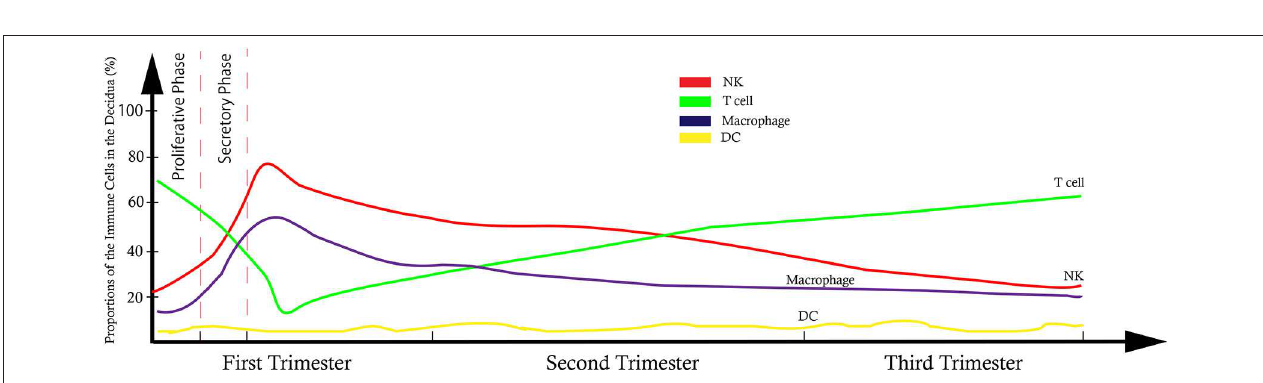
FIGURE 2 | Model of trend line showed the dynamic proportional changes of immune cells at the maternal-fetal interface.